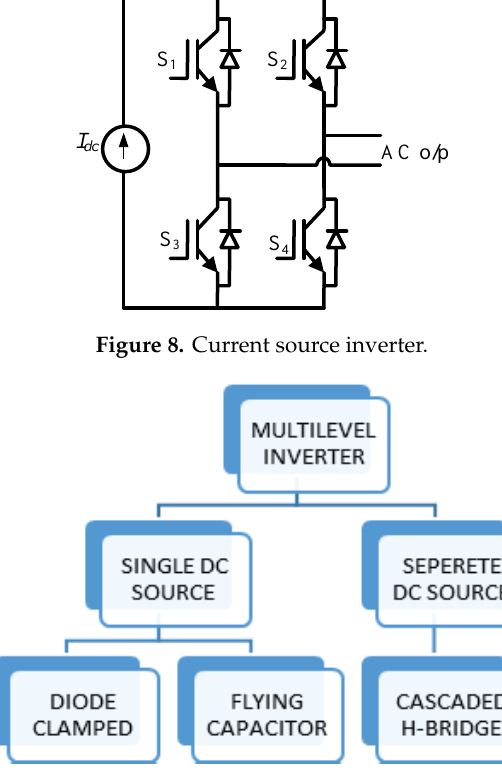
Figure 9. Classification of multilevel inverter topologies. Energies 2019 , 12 , x FOR PEER REVIEW